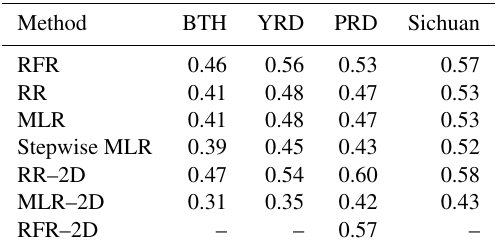
Table 2. Averaged R 2 in the four regions by different machine learning algorithms, namely RFR, RR, MLR and stepwise MLR with only local meteorological predictors, RR–2D, MLR–2D with additional two-dimensional (2D) nonlocal meteorological variables and RFR–2D which is only conducted for the PRD region. In gen- eral, with only local meteorological variables, RFR performs the best with the highest averaged R 2 in four regions. RR–2D and RFR–2D show improvement over the PRD region compared to